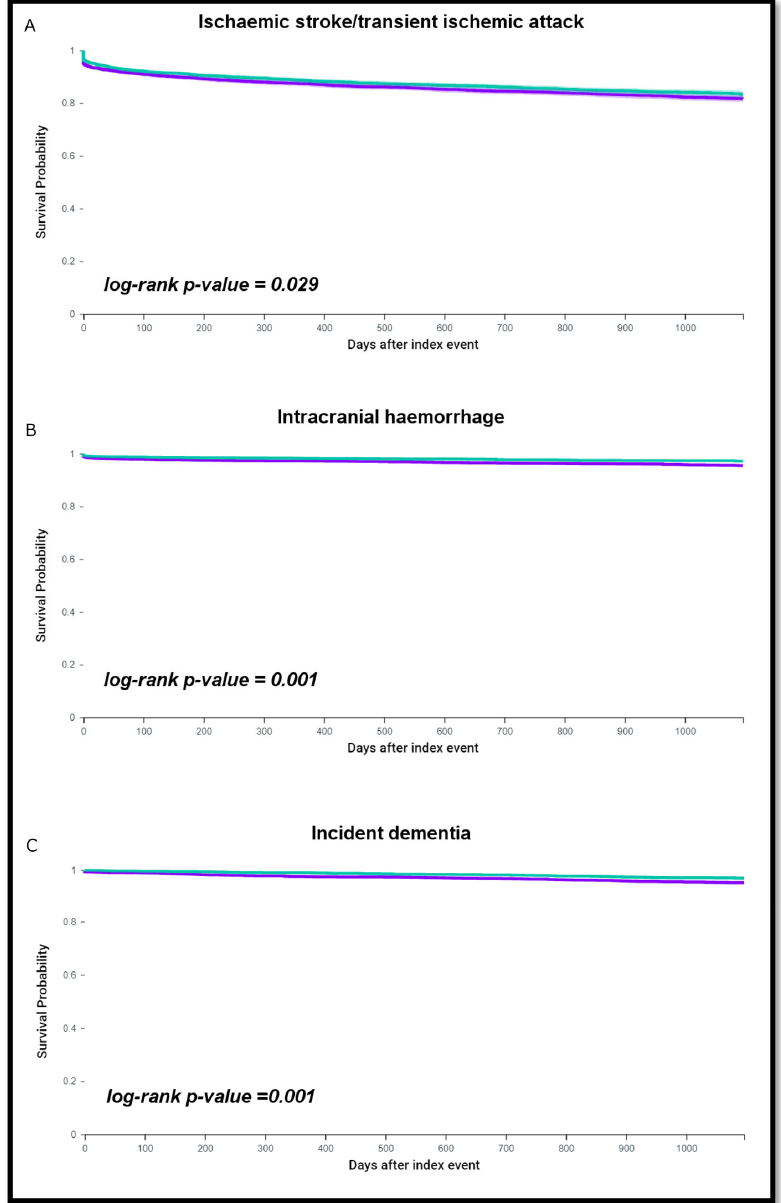
Figure 1. Kaplan–Meier curves showing survival free from ischemic stroke/TIA ( A ), ICH ( B ) and dementia ( C ) in patients on SGLT2 therapy versus without.